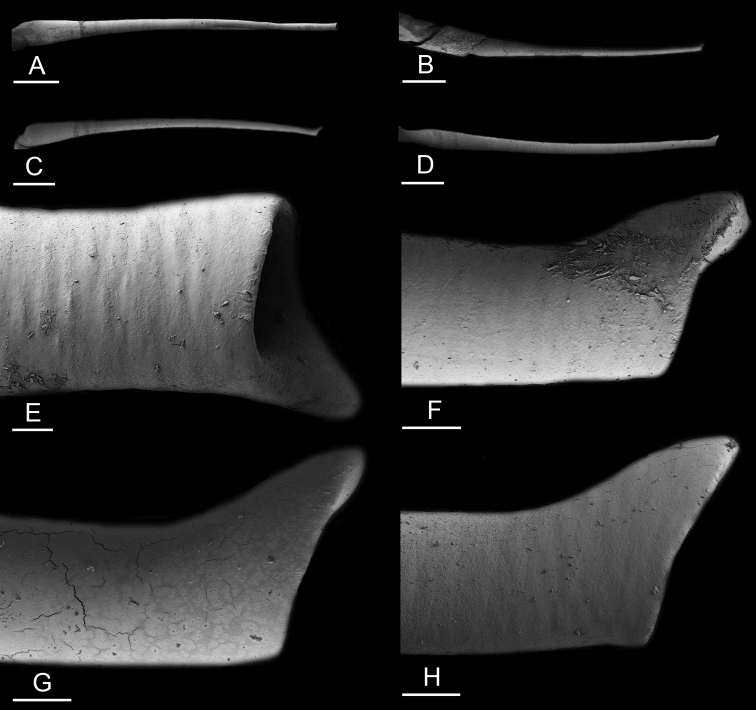
Accessory penial gland spine, Peronia
verruculata, Red Sea A, E spm #1 (ZMH 27472/4) B, F spm #2 (ZMH 27472/4) C, G spm #3 (ZMH 27472/4) D, H spm #4 (ZMH 27472/4). Scale bars: 300 μm (A, C, D), 400 μm (B), 10 μm (E), 20 μm (F–H).